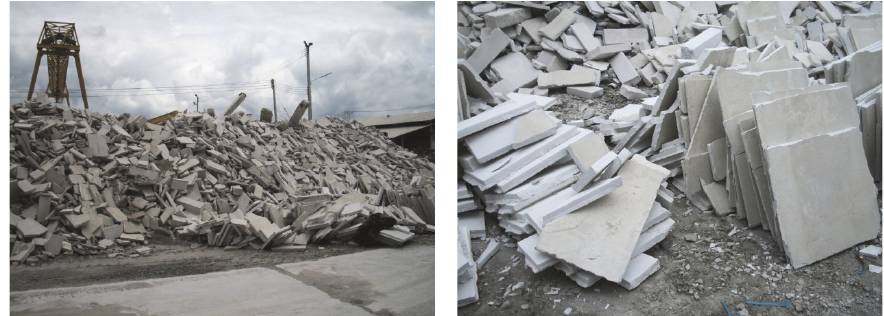
Figure 1: Scraps of AAC block production.